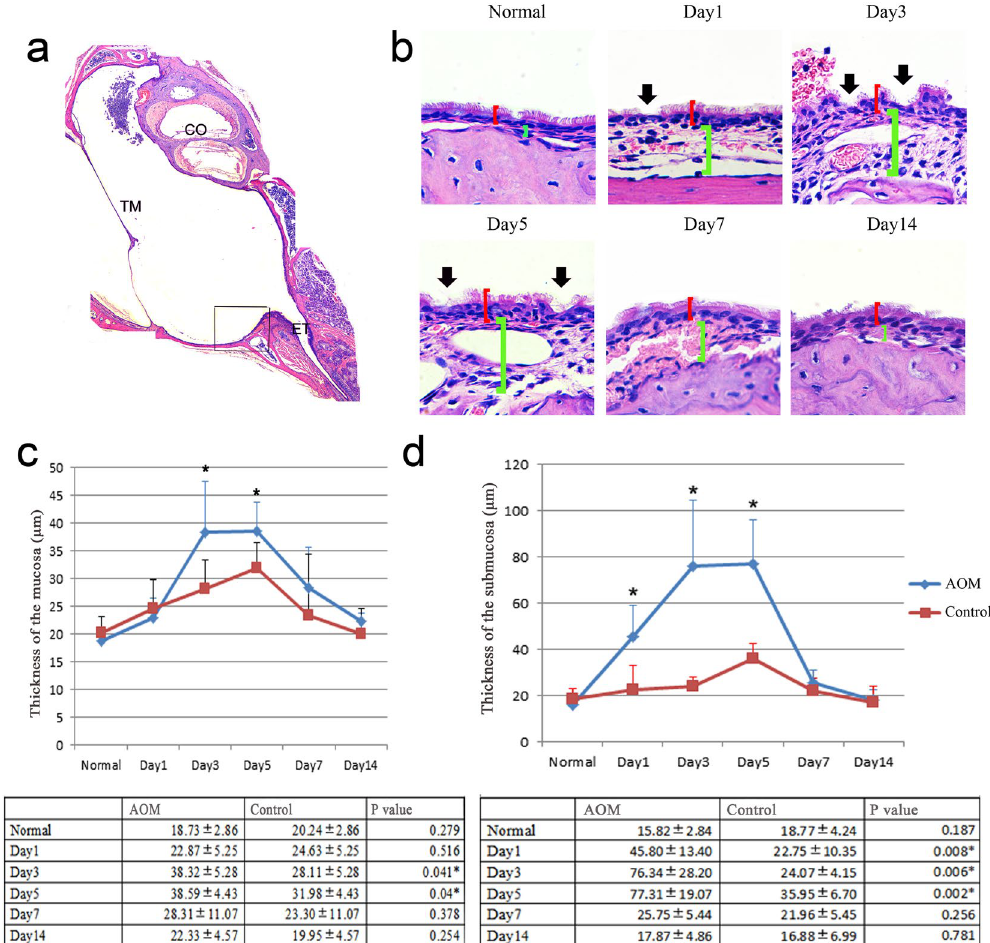
Figure 2. Thickened middle ear mucosa and submucosa in mouse AOM. The same location shown in the box in Fig. 2a in each slide was chosen for measurement. The distance between the apical surface and basement membrane was defined as the thickness of mucosa, and the distance between the basement membrane and the bone surface was defined as the thickness of the submucosa. (n = 6). ( a ) The location of the observation. TM, tympanic membrane; ET, Eustachian tube; CO, cochlea. Scale bar, 500 µ m. ( b ) The thickness of the mucosa and submucosa. Red brackets show the thickness of the mucosa; green brackets show the thickness of the submucosa; black arrows show abnormal cilia. Scale bar, 20 µ m. ( c ) Average thickness of the mucosa in each group at different times following Streptococcus pneumoniae injection. Error bars show S.D. Data are presented as mean + S.D. (n = 6 per group). * p < 0.05. ( d ) The average thickness of the submucosa in each group at different times after Streptococcus pneumoniae injection. Error bars show S.D. Data are presented as mean + S.D. (n = 6 per group). * p <